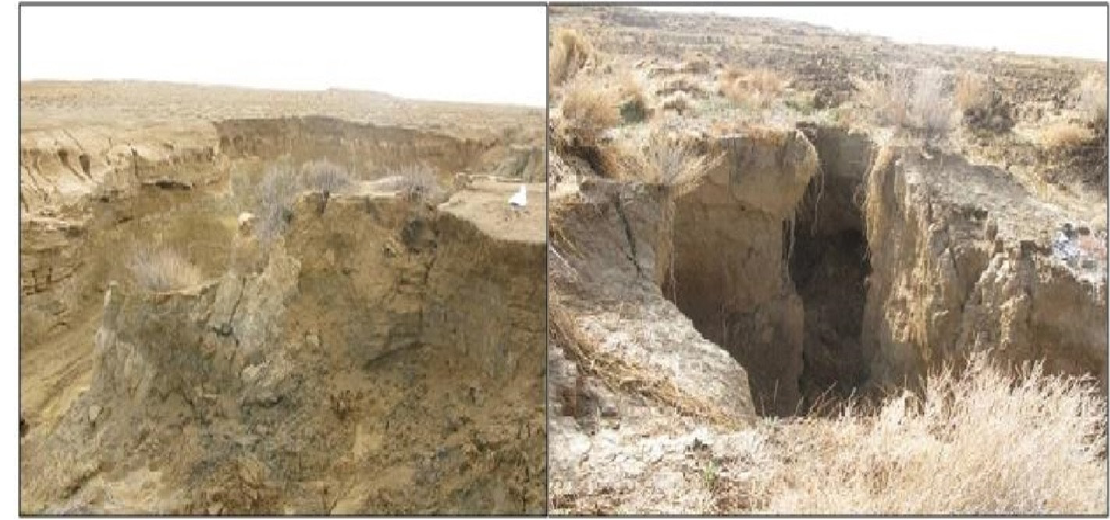
Figure 2. A picture of two gullies created in agriculture land (right) and range land (left) study area.